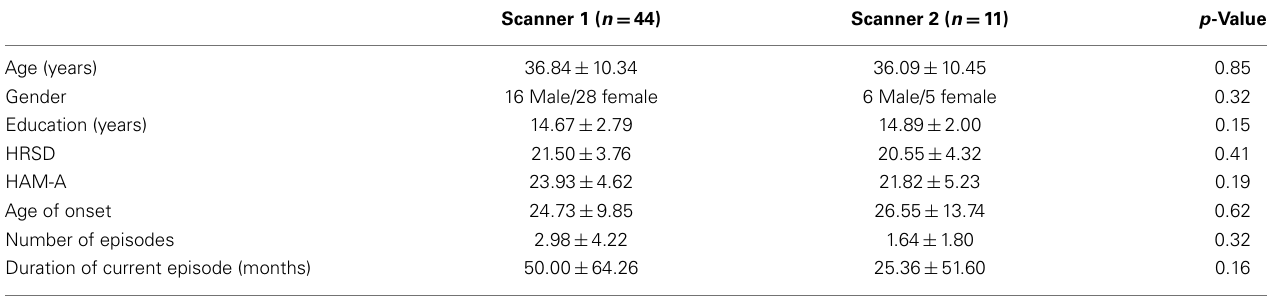
TableA1 | Characteristics of MDD subjects scanned in two